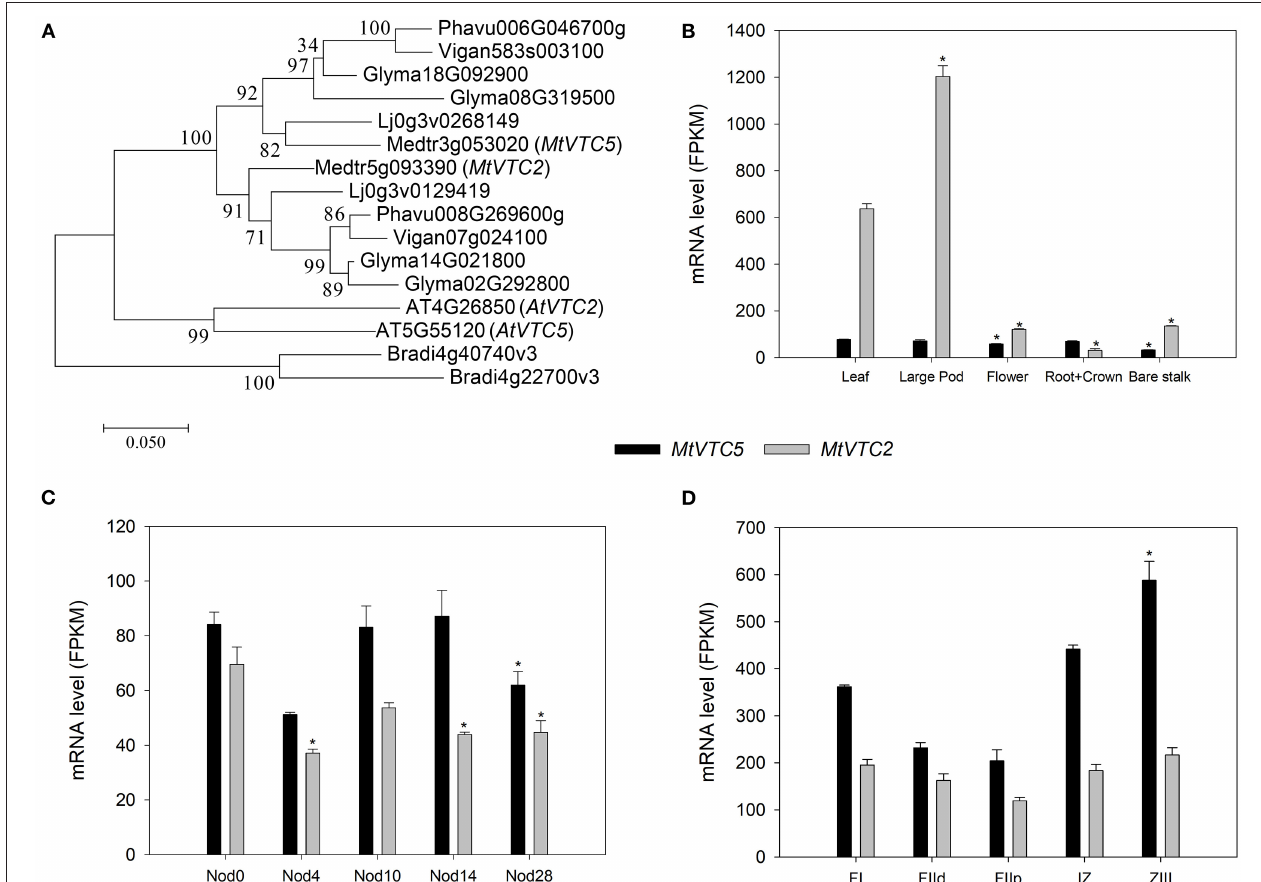
FIGURE 1 | Phylogenetic analysis (A) and RNA-sequencing (RNA-seq) expression data corresponding to the MtVTC2 and MtVTC5 genes. The Maximum Likelihood method was applied to generate a phylogenetic tree (1,000 bootstrap replications) using the software Mega 7 (Kumar et al., 2016). Putative orthologs in A. thaliana , Brachypodium distachyon , Glycine max , Phaseolus vulgaris , and Vigna angularis were retrieved after BLASTP and HMMER analysis at the Ensembl Plants website (http://plants.ensembl.org/). Sequences corresponding to Lotus japonicus were extracted from the Lotus Base using BLASTP (https://lotus.au.dk/blast/) against the Lotus japonicus MG20 v3.0 Proteins database. Data corresponding to gene expression in different plant organs (B) , during nodule development (C) , and regions of a nitrogen-fixing nodule ( D ; FI: apical region; FIId and FIIp: distal and a proximal FII fraction, respectively; IZ: interzone; ZIII: nitrogen-fixation zone) was collected from the M. truncatula Small Secreted Peptide database (MtSSPdb; Boschiero et al., 2020; https://mtsspdb.noble.org/database) and Symbimics website (Roux et al., 2014; https://iant.toulouse.inra.fr/symbimics). Values represent the average ± SE ( n = 3 biological replicates). FPKM, Fragments Per Kilobase Million. Asterisks